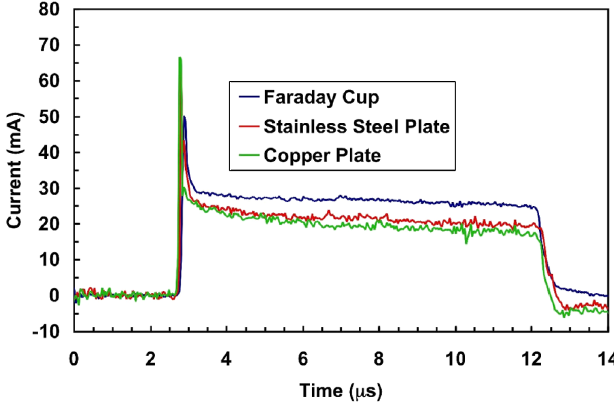
FIG. 16. (Color) Beam current signals collected by the Faraday cup (blue), stainless steel plate (red), and copper plate (green) with both parallel plates biased